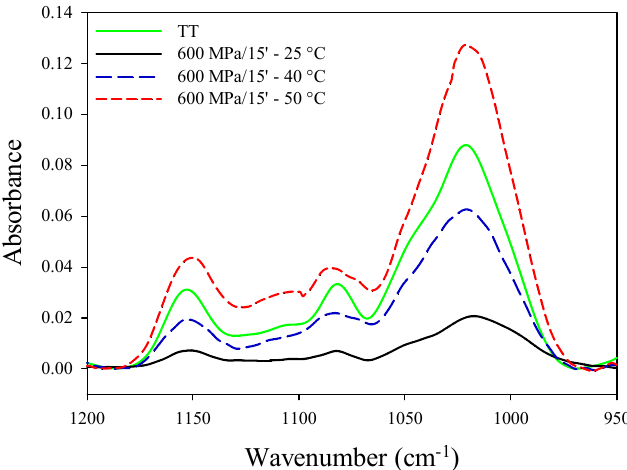
Figure 5. FT-IR spectra of potato starch suspension (20% w / w) treated by HHP at di ff erent processing temperatures.